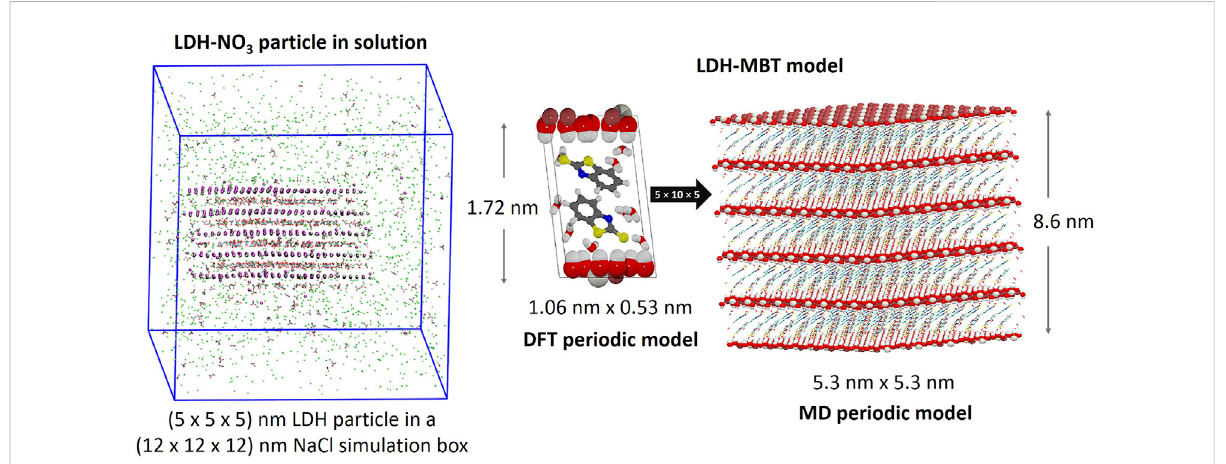
FIGURE 13 MDsimulationsnapshotofanLDH-NO 3 particleinasodiumchloridesolutionsimulatingacorrosionmedium,showingthestabilityofthesystemafter 20ns (left). DFTperiodicmodel, andexpandedMDperiodicmodelusedfor theMDsimulationof LDH-MBT (Colour code for spheres: silver, Al;scarlet, Zn; red, O; white, H; grey, C; blue, N; and yellow, S). Images adapted from references (Pérez-Sánchez et al., 2018; Novell-Leruth et al.,